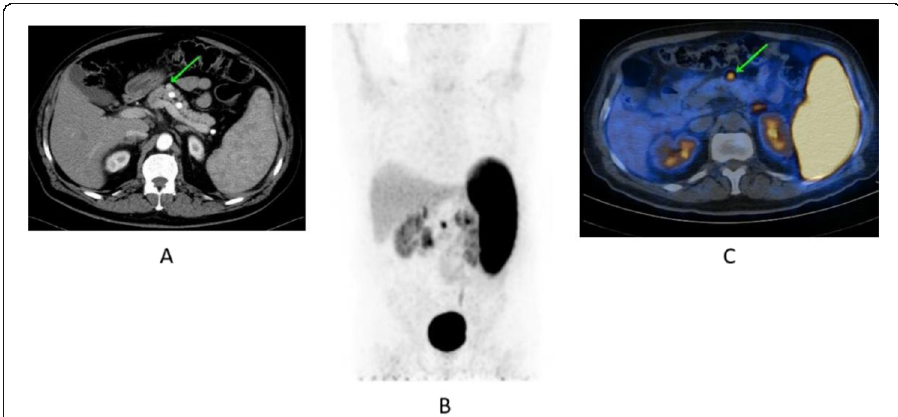
Fig. 48 68 Ga-DOTA peptide, suspected lesion of the pancreas, specificity. Clinical history : 50 y.o. woman; a hypervascular lesion in the pancreas was incidentally found on CT ( a ). PET/CT findings : focal area of high expression of somatostatin receptor analogues in the pancreas corresponding to the CT finding ( b MIP, c fused). Surgery confirmed the presence of a well differentiated neuroendocrine tumour (Ki67 2%)